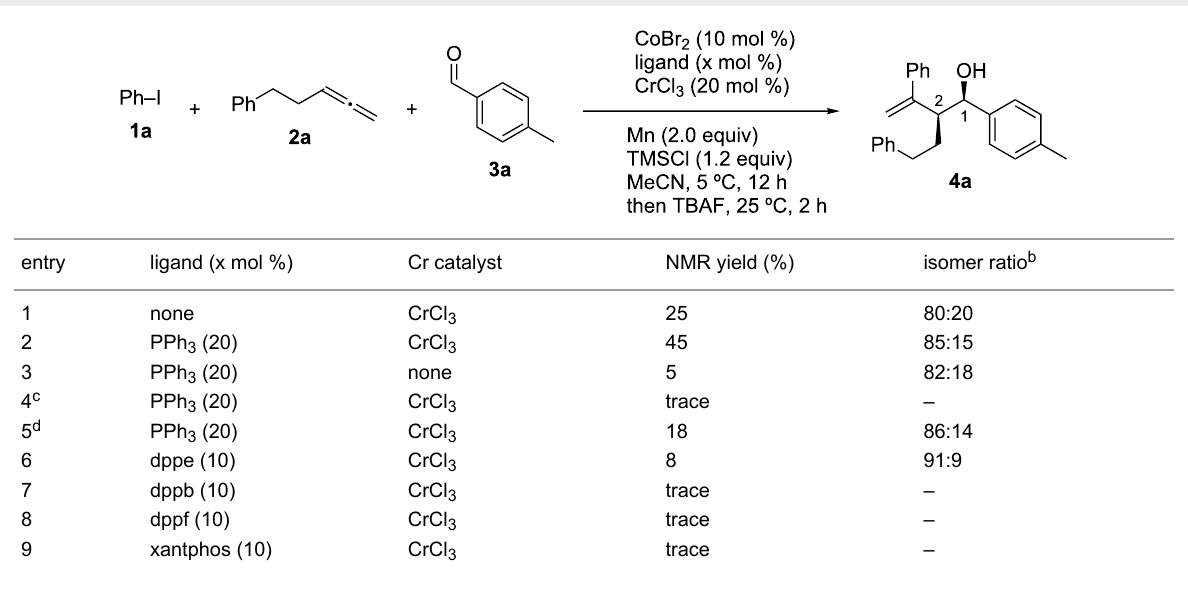
Table 1: Screening of the reaction conditions. a